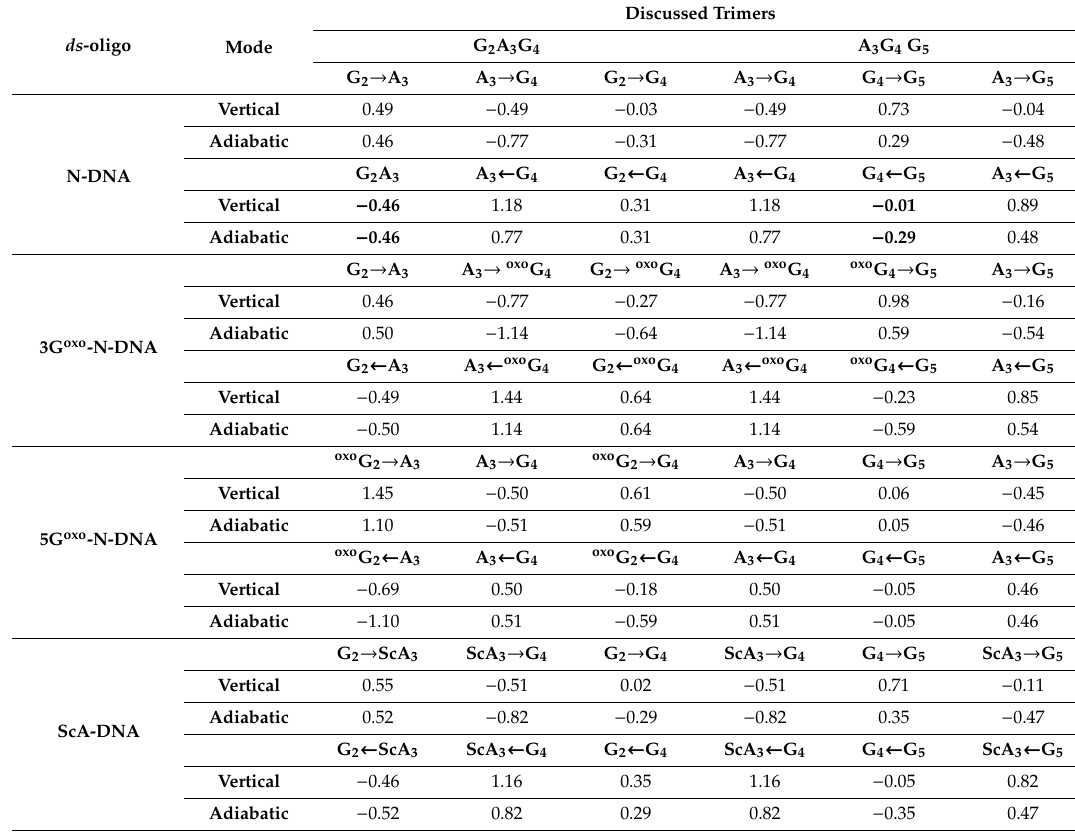
Table 9. Energy barriers (in eV) for radical cation migration between base pairs within trimers. The vertical modes, i.e.. the energies of each base pair’s radical cation, were calculated for their neutral geometry. The adiabatic modes, i.e.. the energies of each base pair’s radical cation, were calculated for their cation geometry. Arrows indicate the direction of the hole transfer from one base pair to another, e.g., A + → G, calculated at the M062x / 6-31 + G** level of theory in the aqueous phase